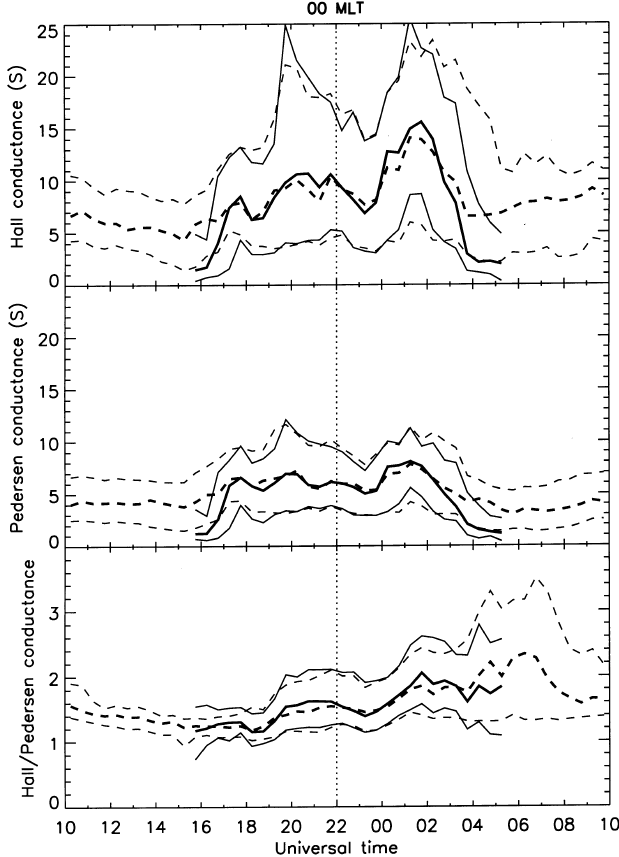
Fig. 1. UT variation of the Hall conductance ( upper panel ), the Pedersen conductance ( middle panel ) and the ratio of the Hall and Pedersen conductances ( lower panel ). The dashed lines indicate the median and upper and lower quartiles of each parameter, binned with respect to universal time with a bin width of 30 min and derived from the complete data set. The full lines are derived from data taken only when the solar zenith angle exceeds 105 (cid:176) . Plots are centred on midnight MLT, which corresponds to 22 UT ( dotted